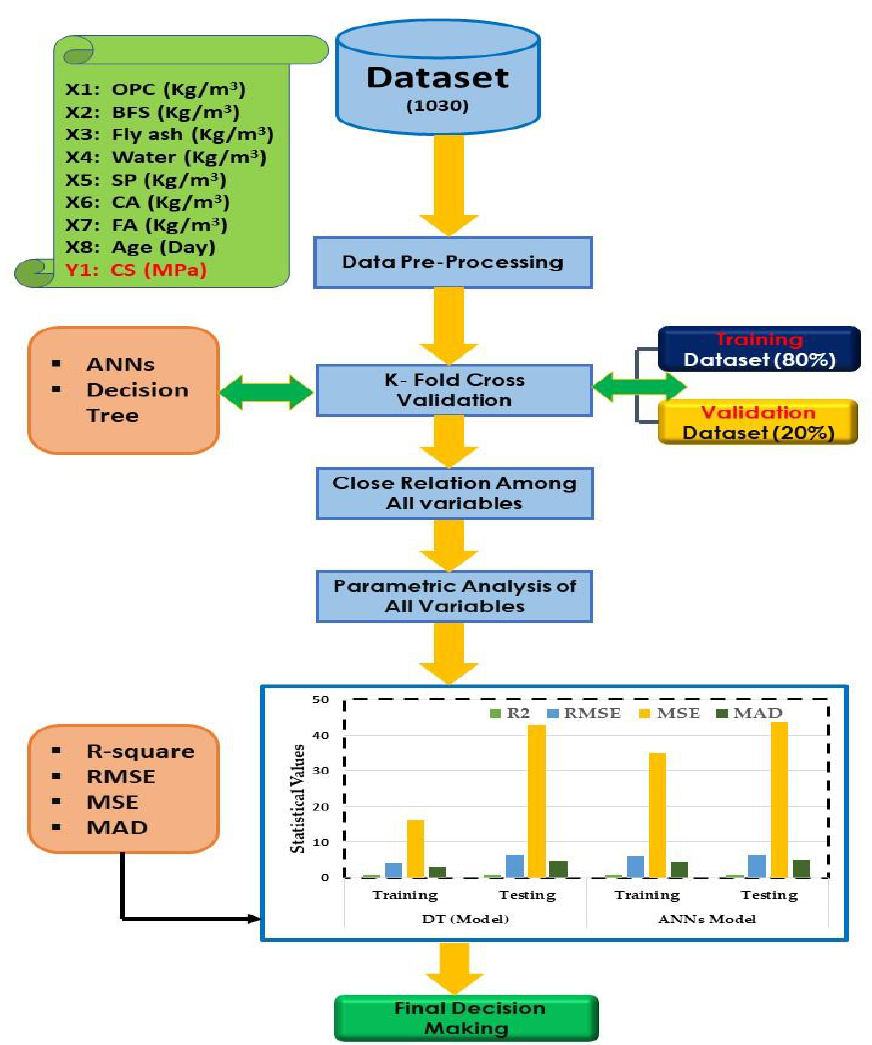
Figure 2. Flowchart of Research Methodology.